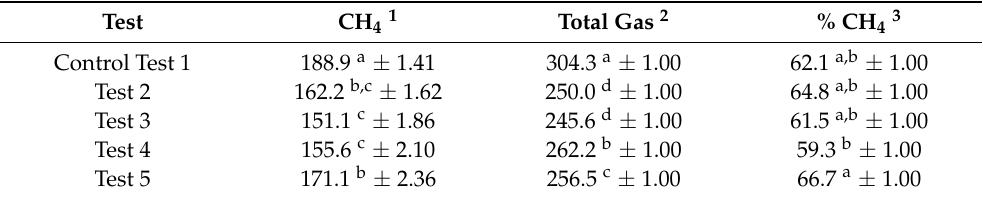
Table 4. Production of methane and total gas at 20 h incubation. Different letters in the same column denote significant differences (a,b,c,d p ≤ 0.05).